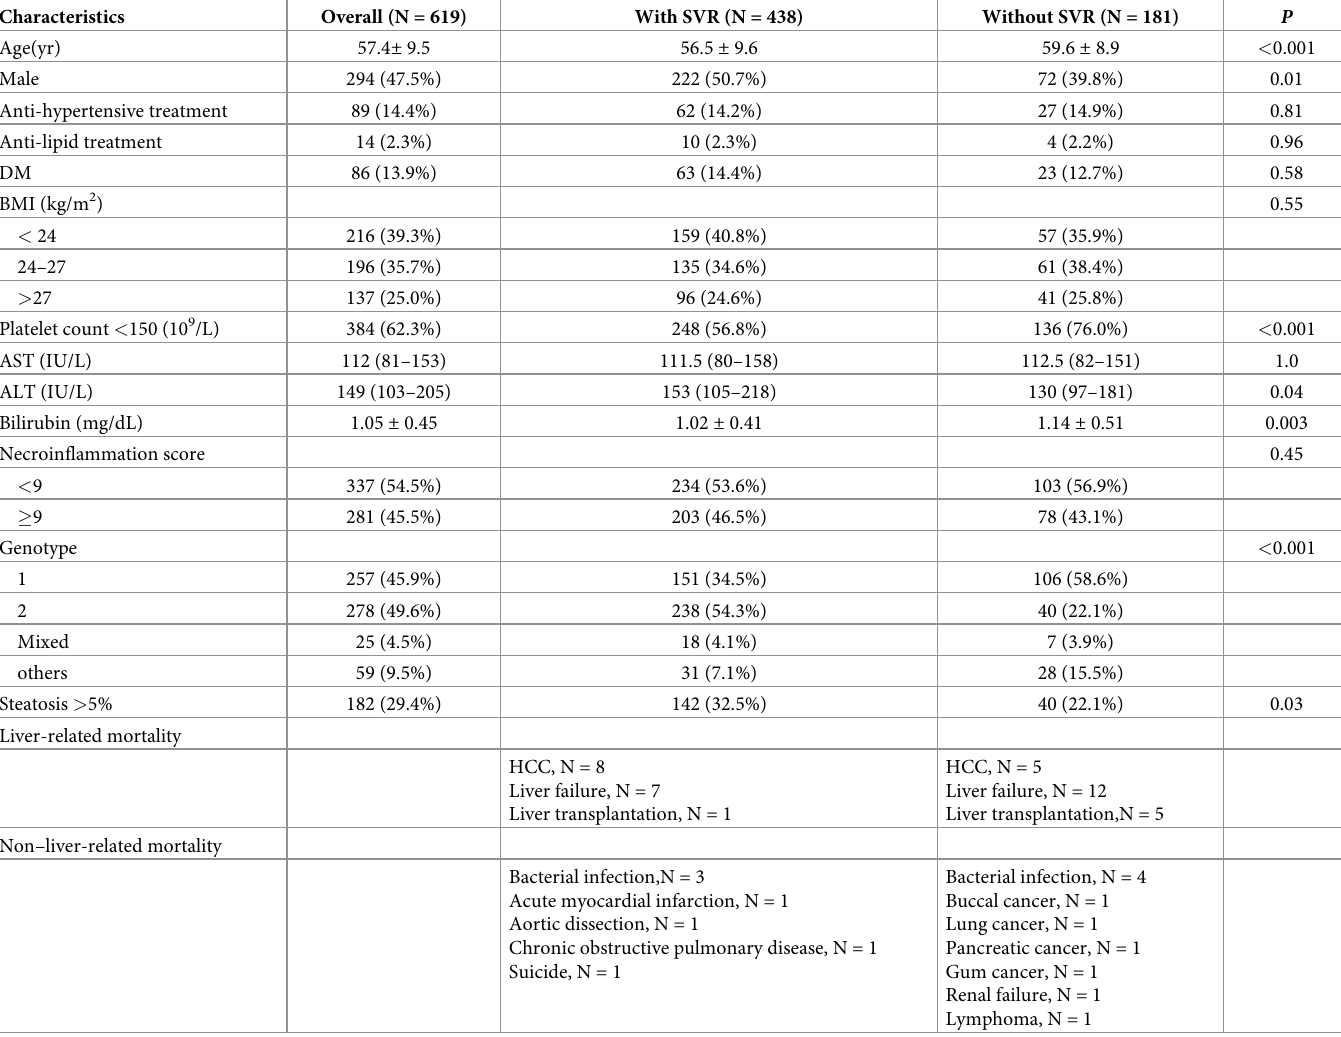
Table 5. Baseline Characteristics According to Treatment Response in advanced fibrotic